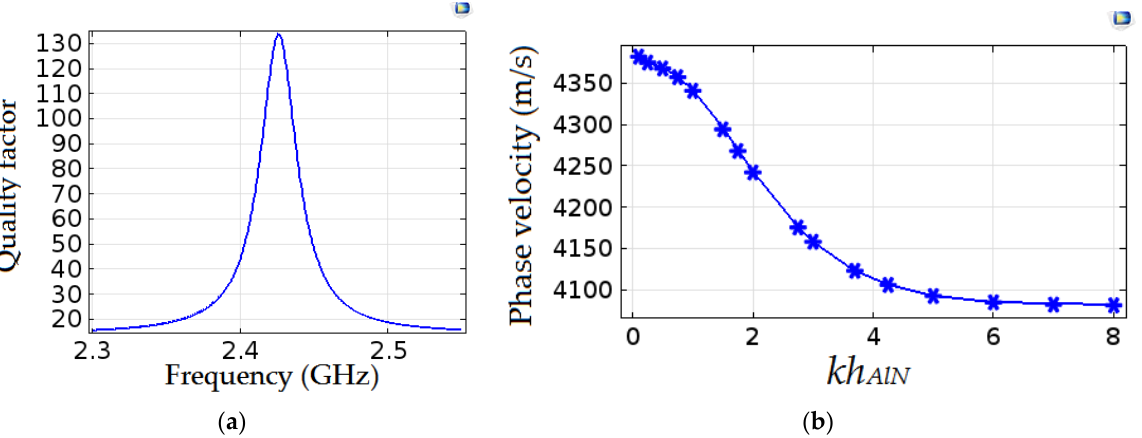
Figure 3 . ( a ) FEM (Finite Element Method) modeling quality factor versus frequency, ( b ) Phase velocity dispersion curve versus normalized AlN (Aluminum Nitride) thickness 𝑘ℎ 𝐴𝑙𝑁 .